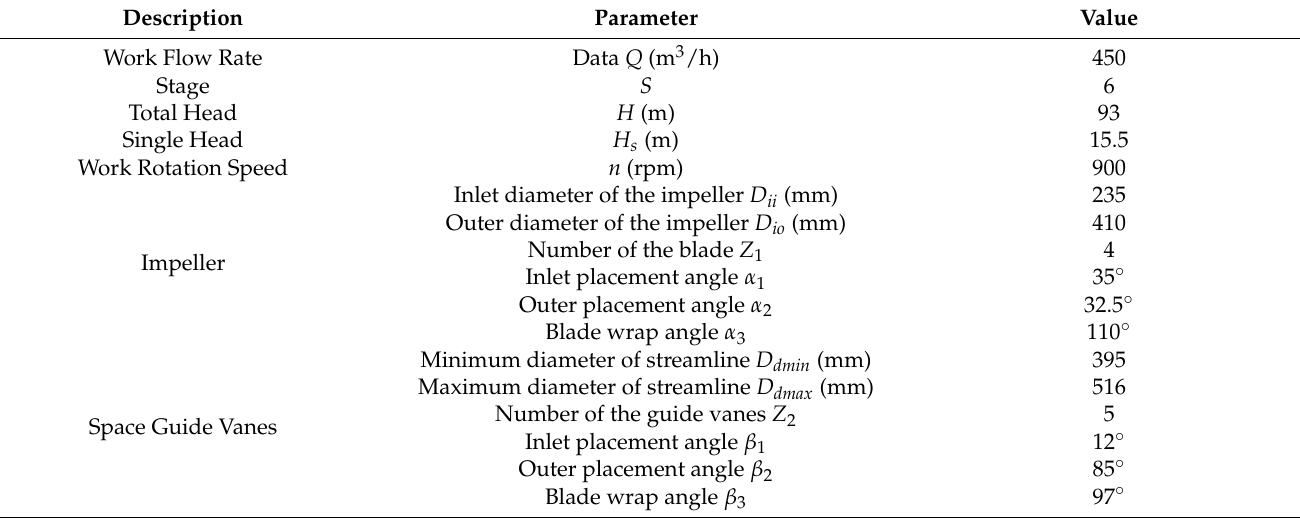
Table 1. The structure and hydraulic parameters of the six-stage lifting motor pump.